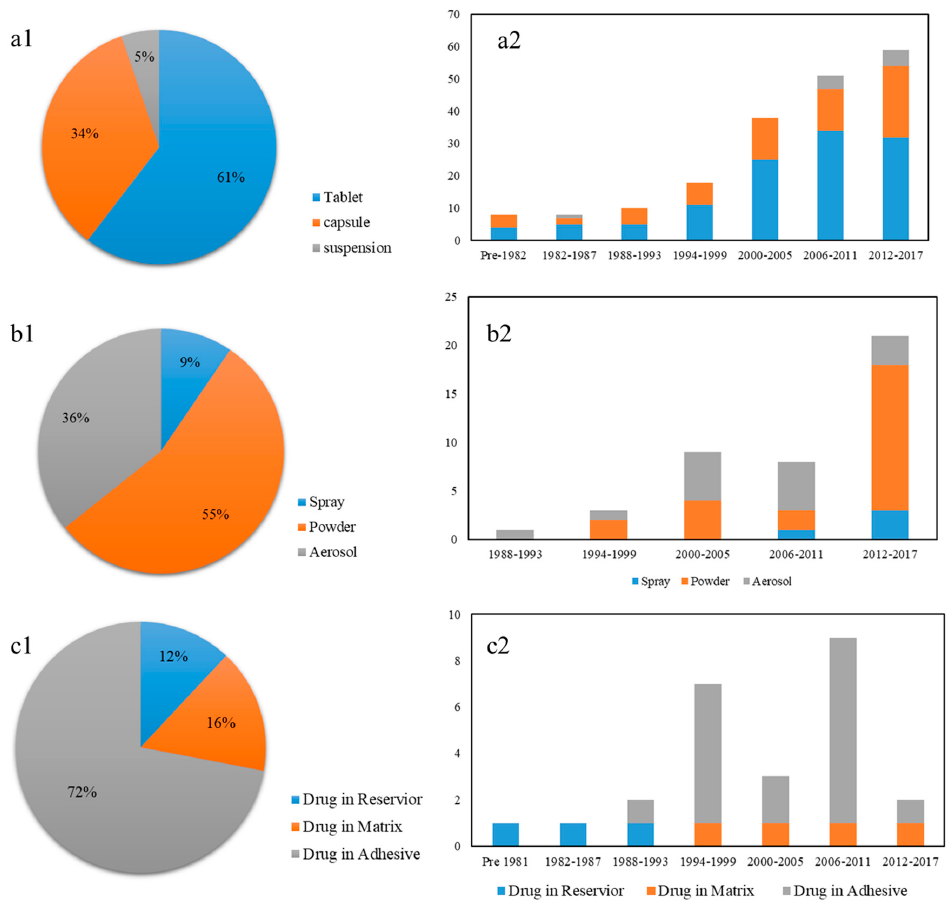
Figure 6. ( a1 ) The distribution of dosage forms of marketed new oral sustained release drugs; ( a2 ) Evolution of oral sustained release preparations. ( b1 ) The distribution of dosage forms of marketed new inhalation drugs: spray; powder; aerosol; ( b2 ) Evolution of new inhalation drugs. ( c1 ) The distribution of dosage forms of marketed new transdermal patches: drug in reservoir, drug in matrix and drug in adhesive; ( c2 ) Evolution of new transdermal patches.